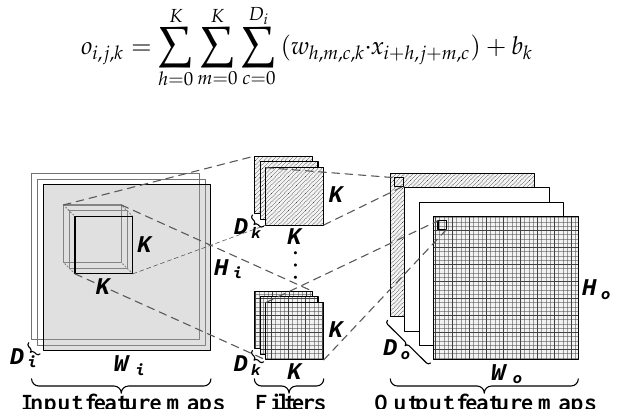
Figure 1. Structure of convolutional neural networks (CNNs): ( a ) structure of a single-channel CNN; ( b ) structure of a multi-channel CNN. Figure 2. Convolution layer of a multi-channel CNN.